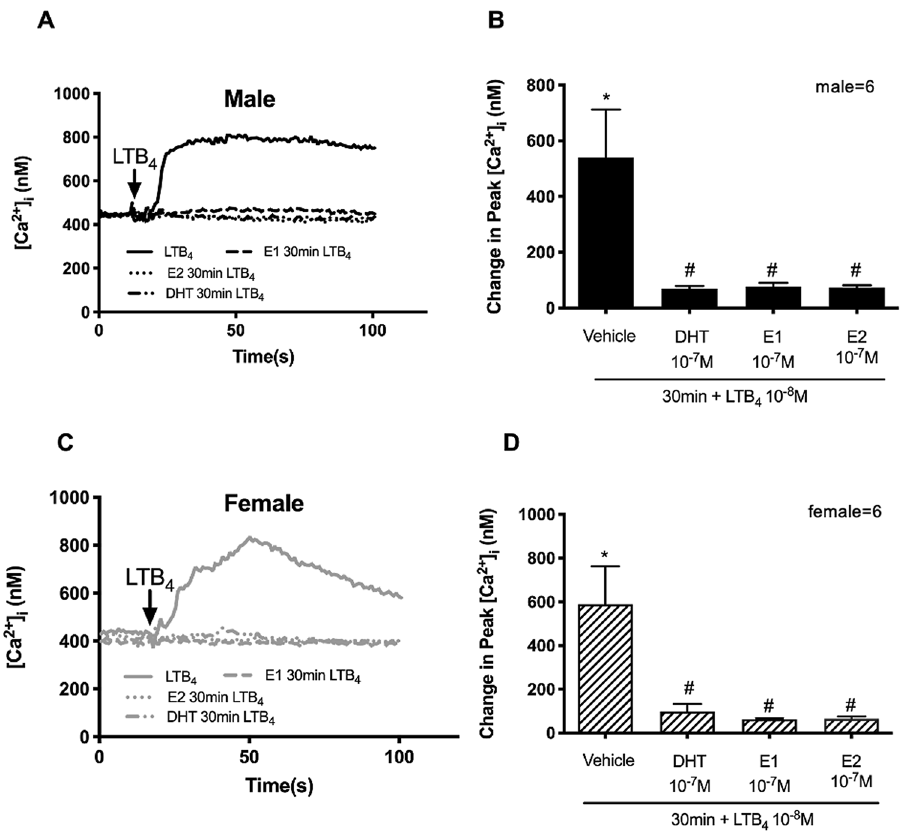
Figure 5. Short-term treatment with sex hormones inhibits the Ca 2+ response from human conjunctival goblet cells cultured from male and female cells to the inflammatory mediator LTB 4 . Cultured goblet cells from male and female conjunctiva were treated with DHT, E1 or E2 (10 −7 M) or vehicle for 30 min prior to addition LTB 4 (10 −8 M). [Ca 2+ ] i was measured by fura2 assay. The average [Ca 2+ ] i level over time was shown in ( A and C ); Change in peak [Ca 2+ ] i was calculated and shown in ( B and D ). Data are mean ± SEM, n = 6 for male cells and n = 6 for female cells. Black lines ( A ) and solid bars ( B ) indicate data from male cells. Grey lines and slash- patterned bars indicate data from female cells. *Significance difference from basal. # Significance difference between male and female